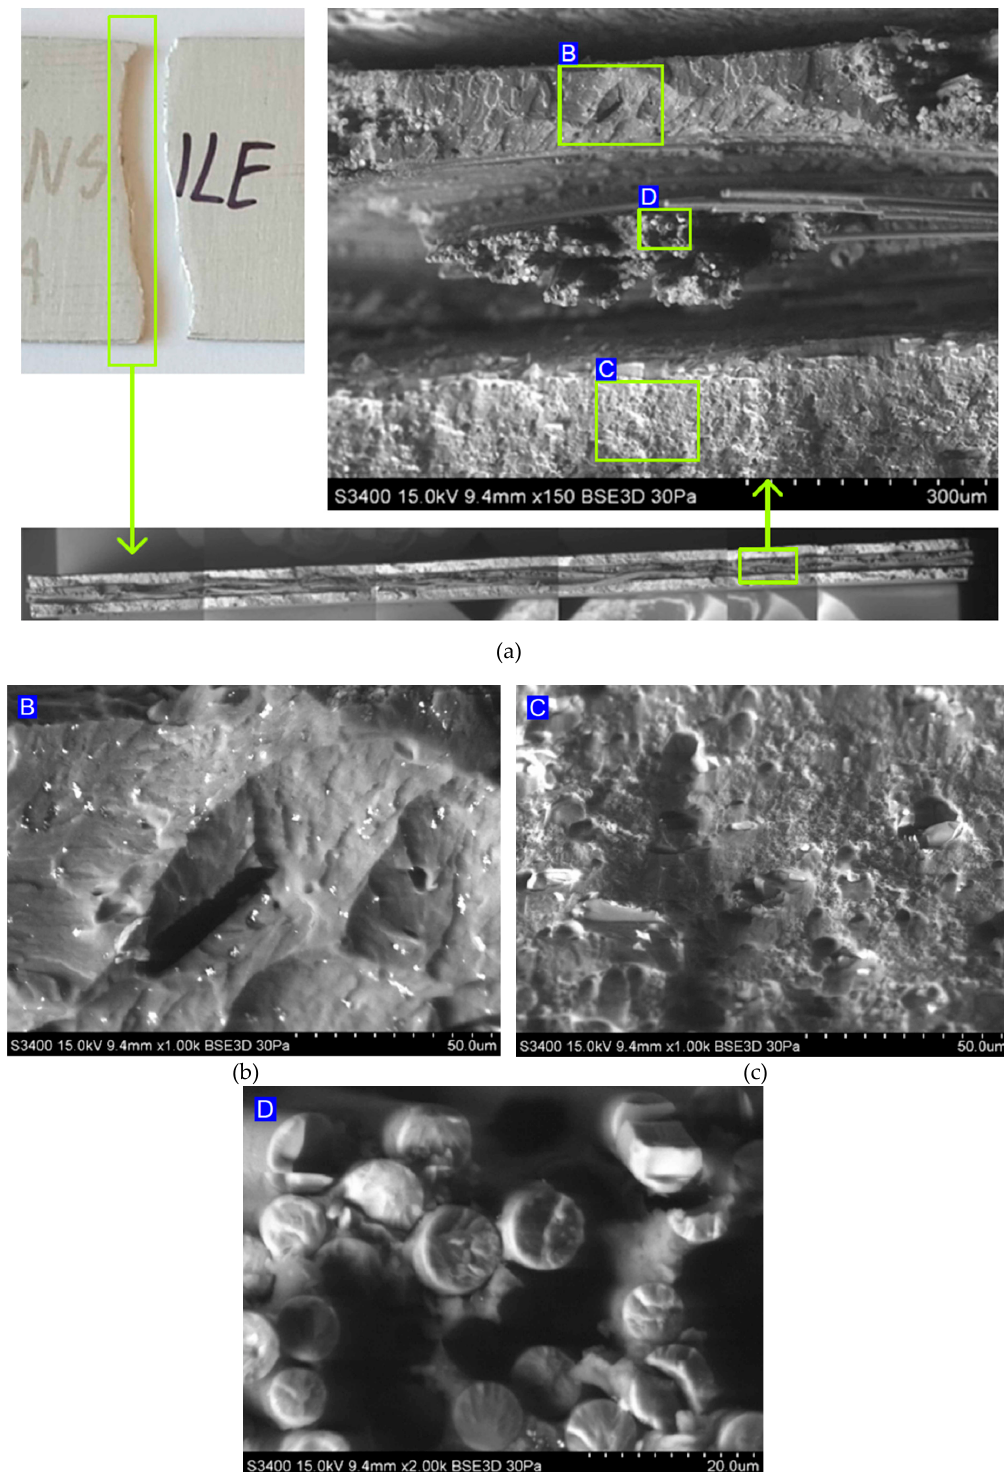
Figure 12. SEM micrographs of the fracture surfaces of samples subjected to the static tensile test at RT: ( a ) view of all layers, ( b ) fracture epoxy resin, ( c ) fracture of sheet metal, and ( d ) broken glass fibres.